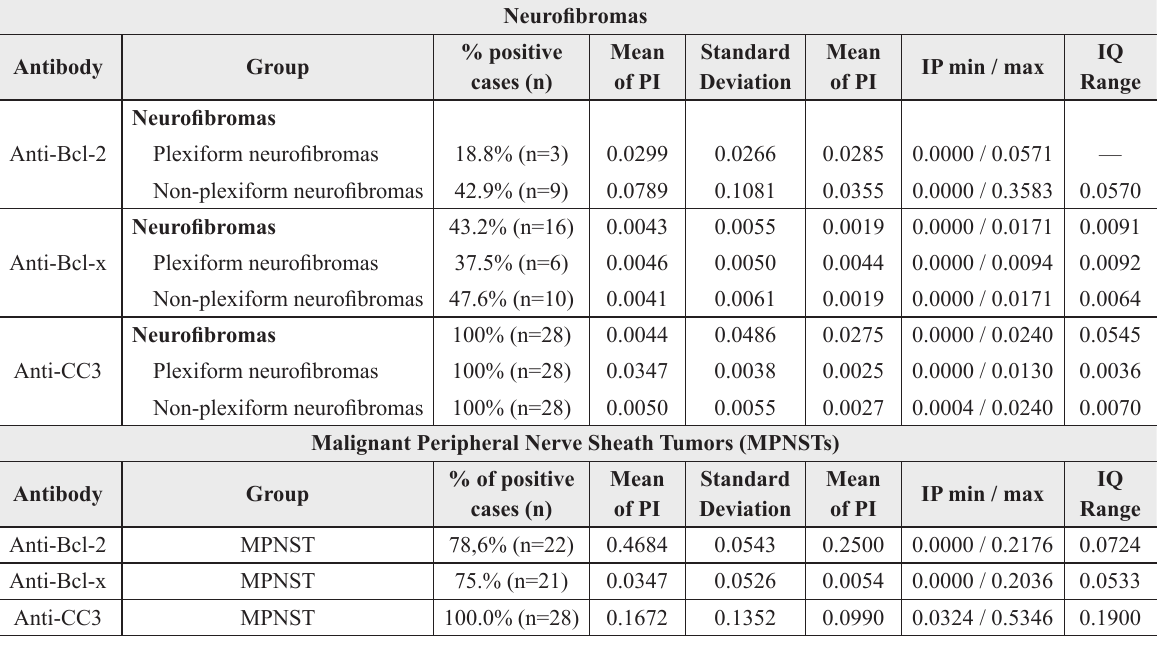
Immunohistochemical data of neurofibromas and of malignant peripheral nerve sheath